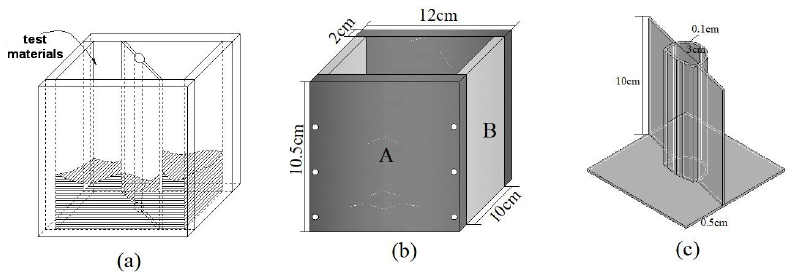
Figure 2. Sample preparation. ( a ) is the process of model preparation. ( b ) is the mold shell. ( c ) is the inner part. The sample preparator consisted of four transparent boards (2 × A, 2 × B) with a thickness of 1 cm. The size of the A board was 12 cm × 10.5 cm × 2 cm, and that of the B board was 10 cm × 10.5 cm × 2 cm.